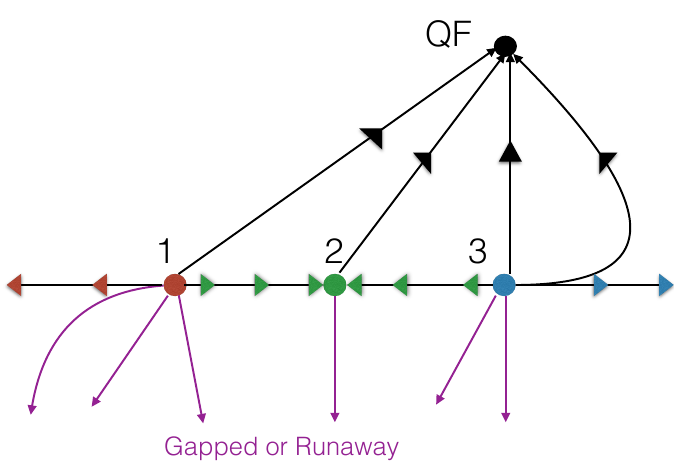
Figure 1. Renormalization group (cid:13)ows of the quasi-bosonic theories as a function of x 6 (the horizontal axis) and of their second-most-relevant deformation x 4 , the coe(cid:14)cient of (cid:30) 4 coupling (the vertical axis), when the most relevant operator is (cid:12)ne-tuned to